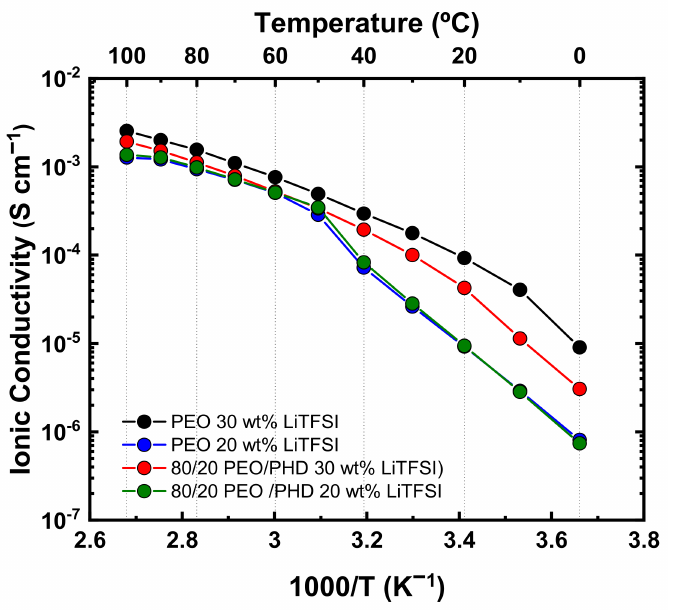
Figure 7. Ionic conductivity as a function of temperature for PEO and 80/20 PEO/PHD blends with the either 20 or 30 wt% LiTFSI, as indicated in the inner